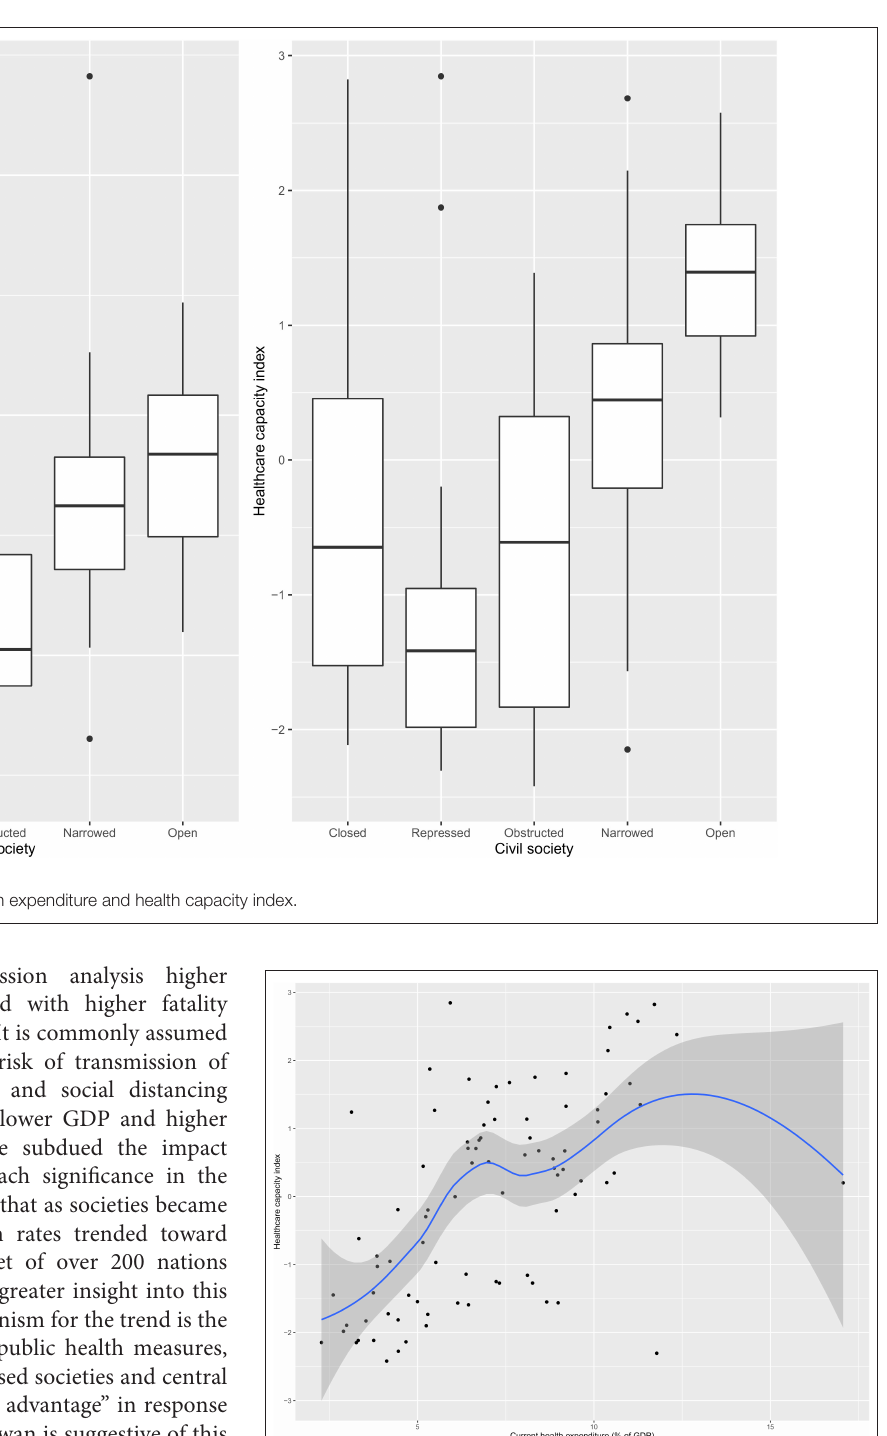
considered public health response will likely emerge in the coming